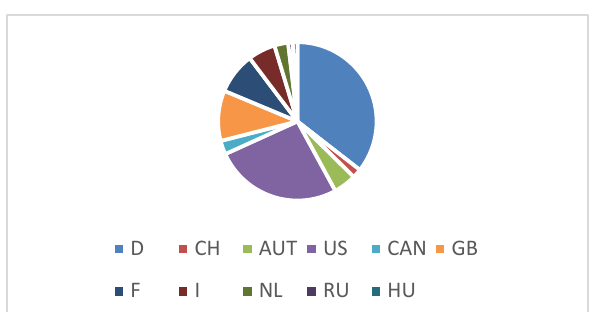
Figure 1 . Countries of origin of investigated image